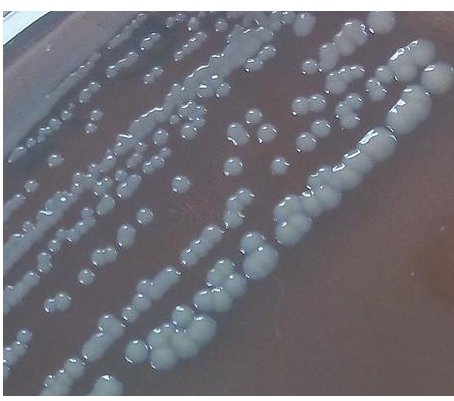
Figure 1. Morphotype Soft and Completely White (SCAW) produced by Salmonella strains at 6 °C.